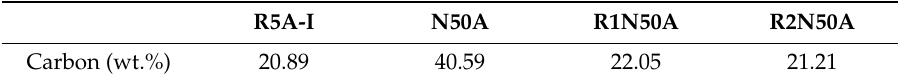
Figure 7. Scanning electron micrographs of ( a ) R5A-I, ( b ) N50A, ( c ) R1N50A, and ( d ) R2N50A. Table 4. Amount of carbon on the catalytic surface of R5A-I, N50A, R1N50A, and R2N50A after 5-hour reactions of DHM fuel.